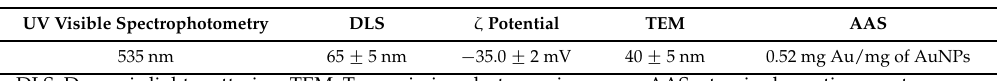
Physicochemical parameters of epigallocatechin-3-gallate (EGCg)-coated-gold nanoparticles (EGCg-AuNPs).